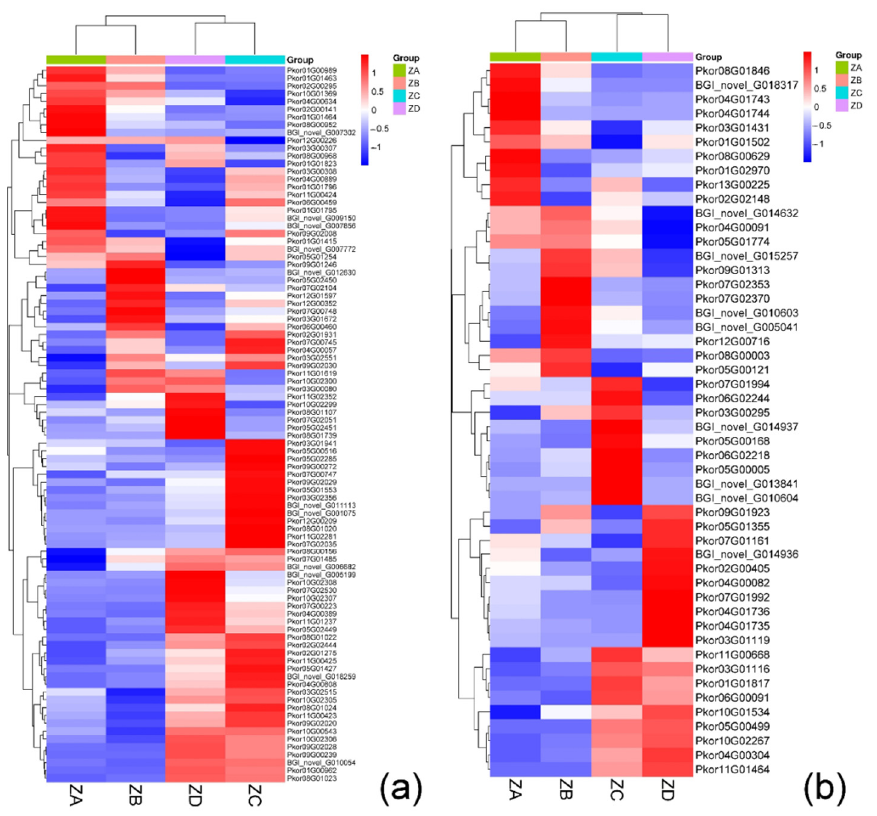
Figure 5. ( a ) Expression of auxin-related differential genes in Korean pine; ( b ) Expression of cytokinin-related differential genes in Korean pine.